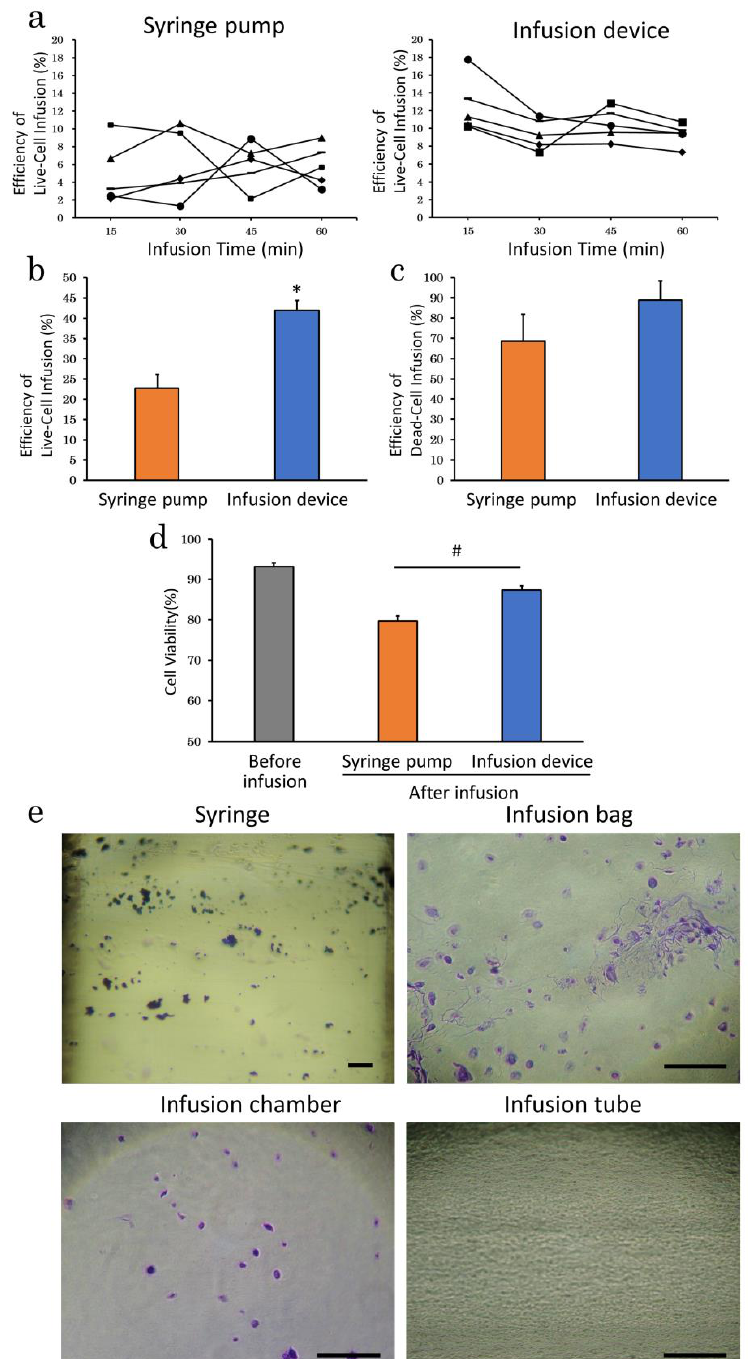
Figure 2. Infusion apparatus experiments. ( a ), Efficiency of live-cell infusion every 15 min using syringe pump ( left panel) and infusion device ( right panel). Each broken line represents the results of five independent experiments ( n = 5); ( b ), Efficiency of live-cell infusion over 60 min. The infusion device increased efficiency of live-cell infusion approximately two-fold compared with the syringe pump; ( c ), Efficiency of dead-cell infusion over 60 min; ( d ), Cell viability after 60 min infusion. The cell viability using an infusion device was significantly higher than using a syringe pump; ( e ), Adherent cells in the apparatuses stained by Giemsa staining. cADSC adhered to various parts of the infusion apparatuses. No cell adhesion was observed in the tubes. * p < 0.01 vs. syringe pump. # p < 0.01, between groups. Bar = 200 µ